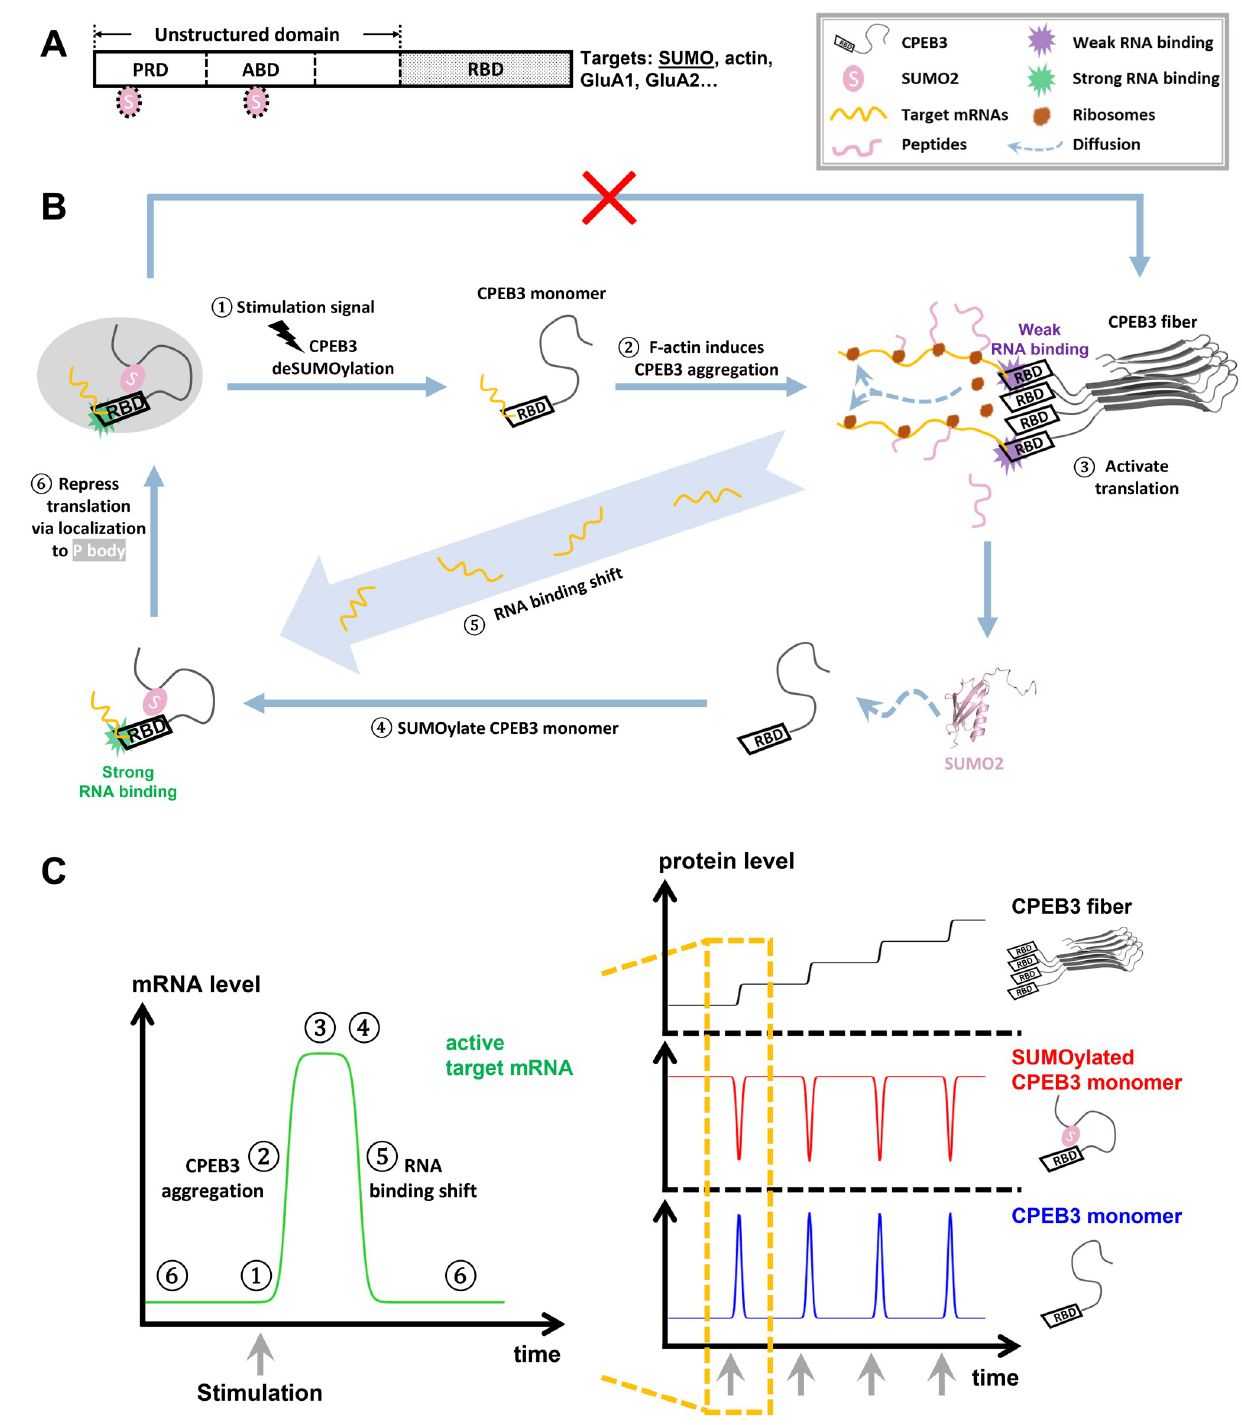
Fig 8. A . The two potential SUMOylated sites on CPEB3 are highlighted using two SUMO2 labels (pink). B . The complete negative feedback loop between CPEB3 and SUMO2: ① An external signal stimulates the synapses and triggers the deSUMOylation of basal CPEB3. ② CPEB3 exposes its prion-like domain (PRD) and actin-binding domain (ABD) and aggregates upon binding with actin filaments (F-actin). ③ CPEB3 fibers form local translation factory assembly lines to activate the translation of its target mRNAs, which includes SUMO2 mRNA. ④ Newly synthesized SUMO2 proteins are then used for the SUMOylation of monomeric CPEB3. ⑤ A shift of mRNAs from binding with CPEB3 fibers to binding with SUMOylated CPEB3 occurs due to the RNA- binding affinity difference. ⑥ SUMOylated CPEB3 binds with target mRNAs and recruits them into P bodies for translational repression. A legend is